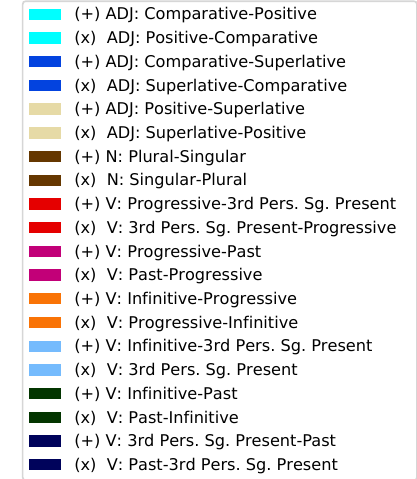
Figure 4: t-SNE visualization of all demo relation pairs from English validation set embedded using the relation encoder. Each point is colored by the relation type that it represents Table 6: Prediction accuracy of the proposed model without attention mecha- nism, without the first (source) word in the demo relation, and completely with- out demo relation encoder, respectively. English validation